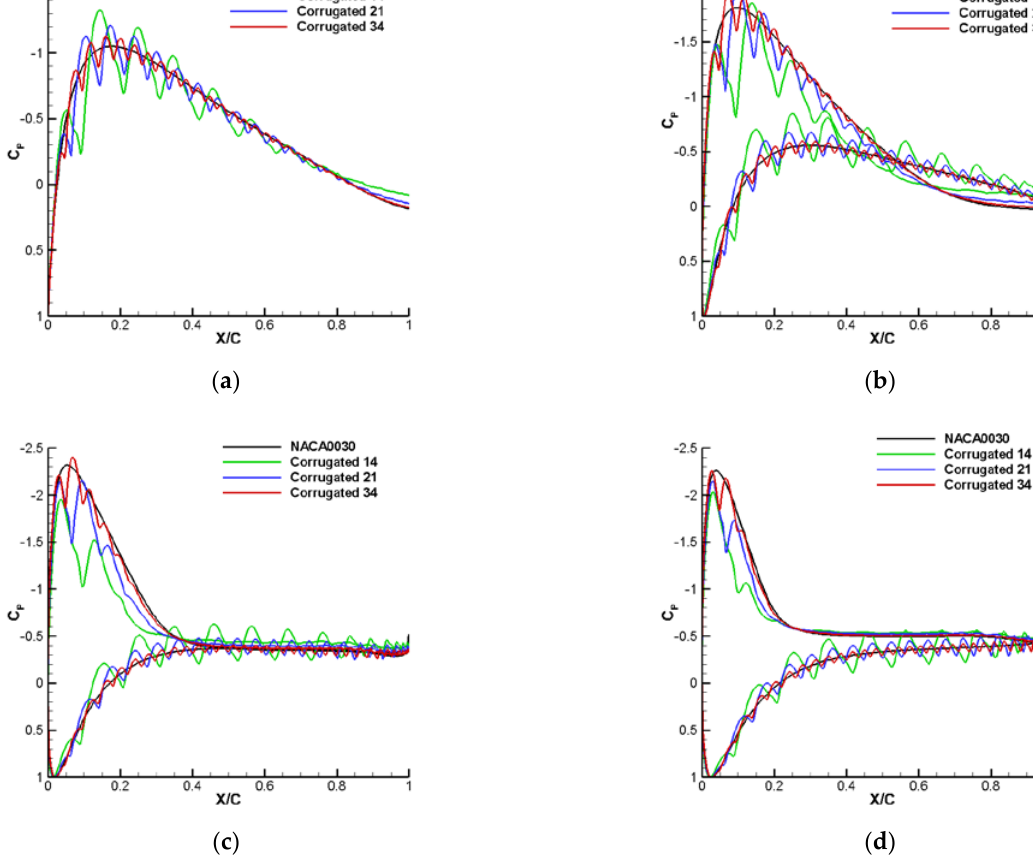
Figure 7. Comparisons of wall pressure coefficient at different angles of attack: ( a ) 0°, ( b ) 8°, ( c ) 16°, and ( d ) 20°.